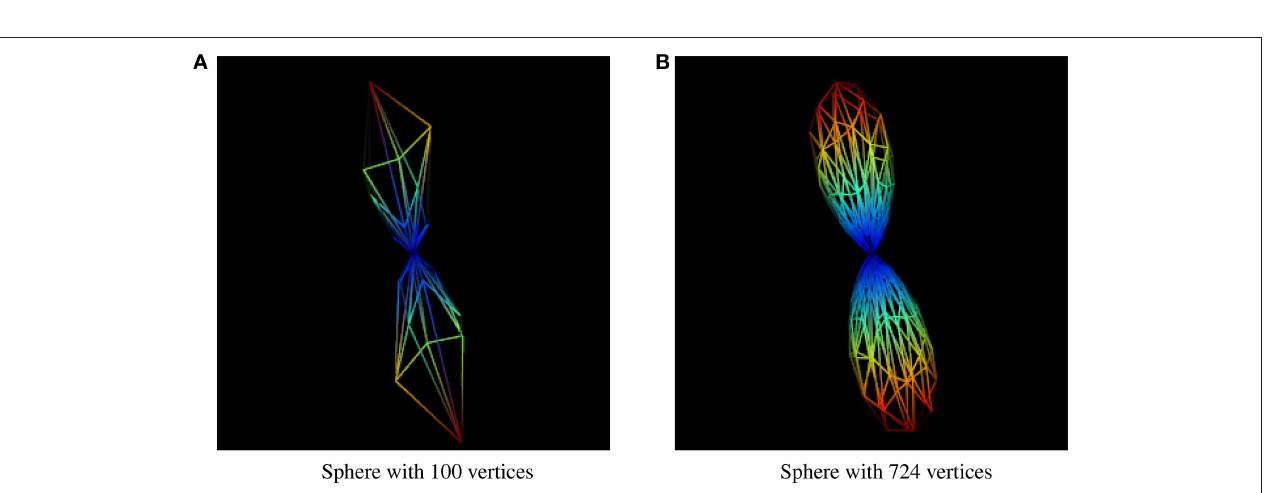
FIGURE 10 | fODF represented by spheres of different resolutions. (A) fODF represented by a sphere of 100 vertices. (B) fODF represented by a sphere of 724 vertices.